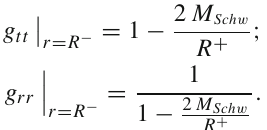
Fig. 2 Effective thermodynamic quantities for different values of α when the constrain over the anisotropy mimics a standard pressure θ r = p . The solid black line represents the Durgapal–Fuloria solu- r tion given by α = 0; α = 0 . 15 (dashed red line) and α = 0 . 3 (dotted